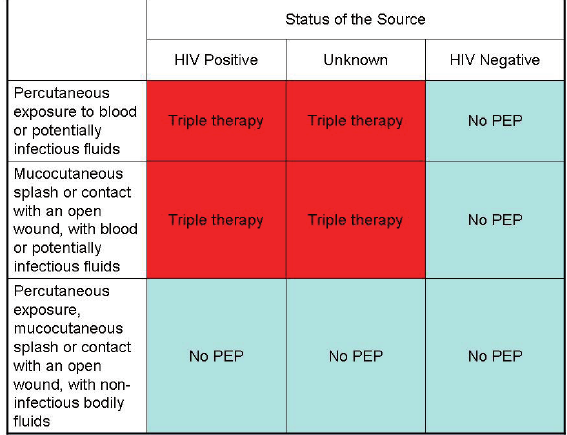
Fig. 1. Selecting patients for PEP